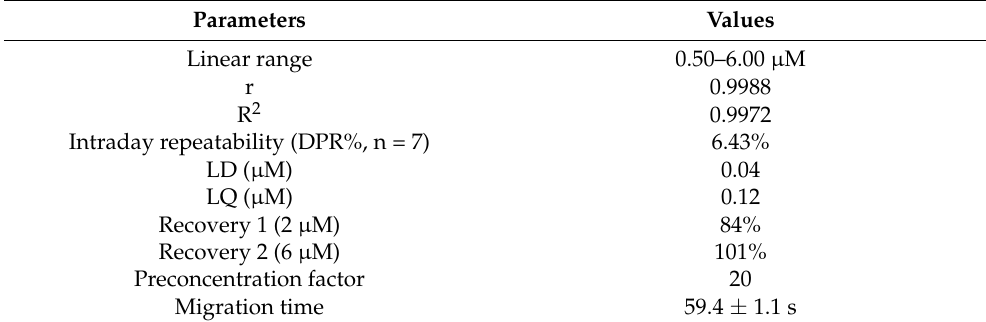
Table 4. Summary of the analytical parameters of the proposed MISPE-DPX-CE method for the determination of SCP.